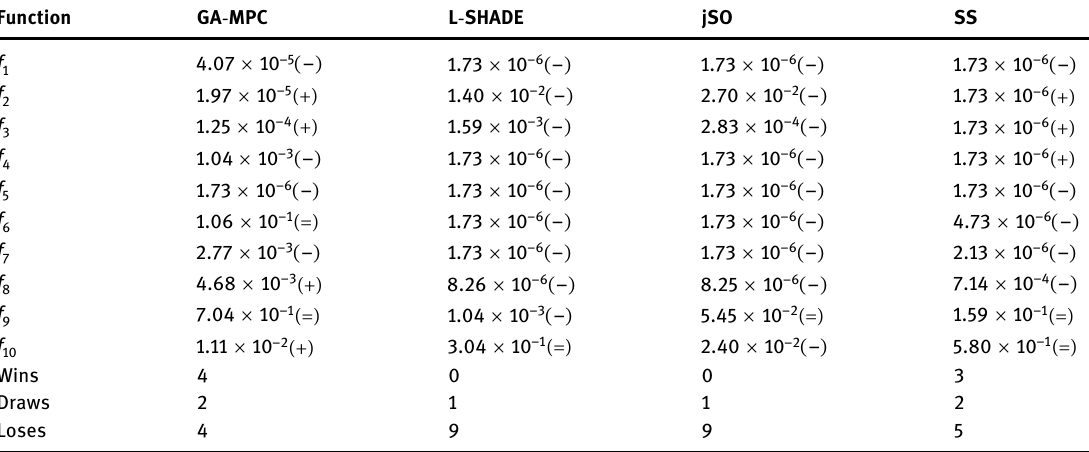
Table 15: The CEC 2020 ( = D 10 ) statistical analysis showing the Wilcoxon test p - value